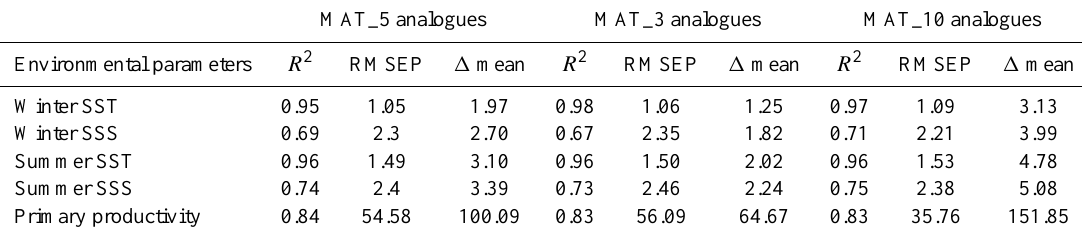
Table 2. Results of validation test for the reconstructions of the winter and summer sea-surface temperature (SST) parameters, salinity, and primary productivity based on the database comprising 1207 reference sites (see Sect. 3.4) with 3, 5 and 10 analogues; R 2 is the correlation coefficient between observed and estimated values. The RMSEP (Root Mean Square Error of Prediction) is calculated by dividing the database into calibration and verification data sets. 1 mean refers to the mean of the ranges between the estimated minimum and maximum